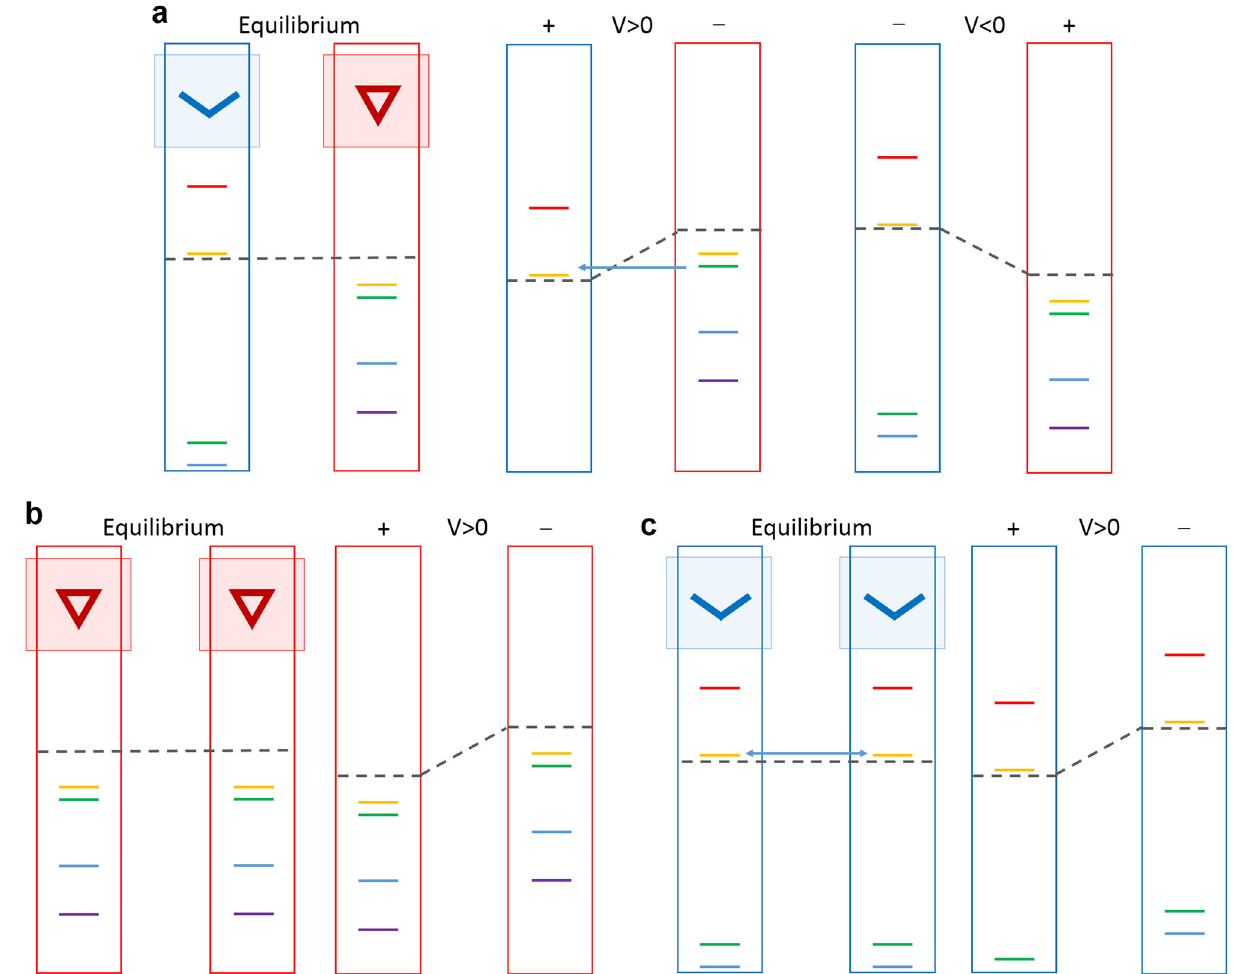
Fig. 7 Molecular energy level alignment for backward diode, resistor and tunnel diode effects of SMJ. Molecular energy level alignments at different voltages are shown for PDT&CPDT a , CPDT&CPDT b and PDT&PDT c junctions respectively. The arrows show the directions of electronic resonant tunneling. The color of the levels corresponds to those in Fig.